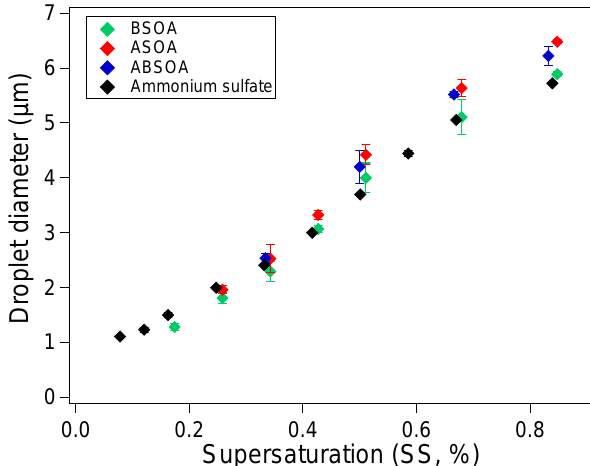
Figure 3. Droplet sizes of BSOA, ASOA, ABSOA, and ammonium sulfate aerosols at various supersaturations (SS). In the CCNC, all SOA particles reached comparable droplet sizes compared to am- monium sulfate.